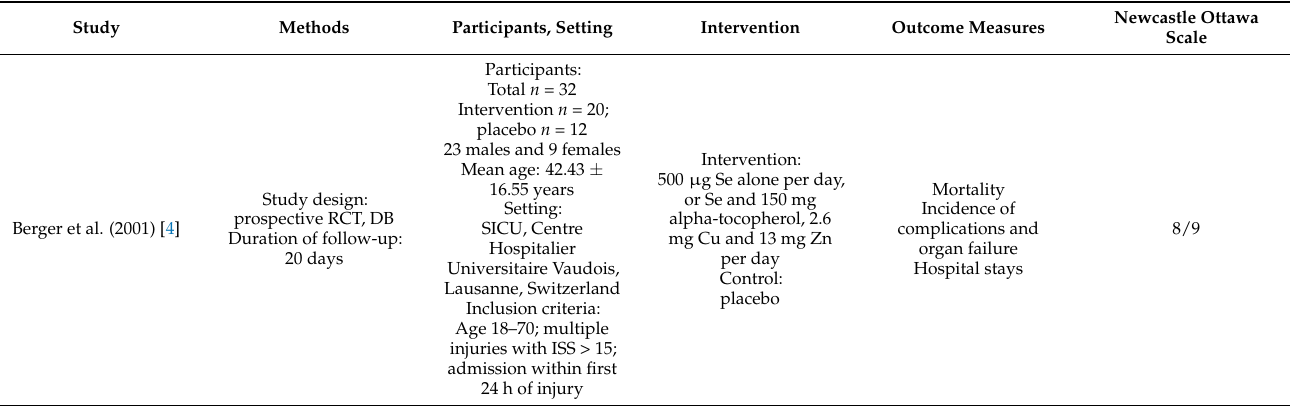
Table 2. Characteristics of included